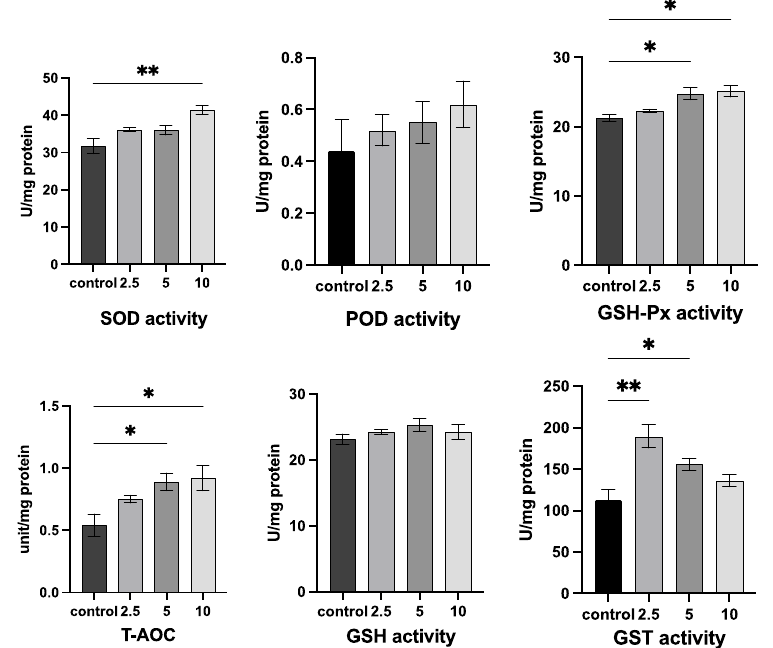
Figure 4. Changes in antioxidant enzymes (SOD, POD, GSH-Px, T-AOC, GSH, and GST) and T-AOC in O. potamophila after exposure to quercetin for 21 days. Mean ± SD ( n = 6 for the treatment and CK group). Significantly different from control values (* p < 0.05, ** p < 0.01).